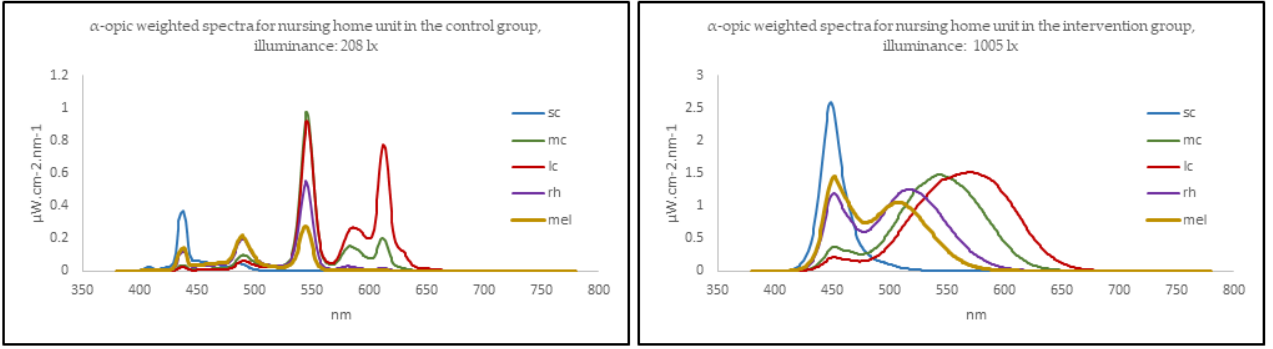
Figure 3. Typical α -opic weighted spectra for nursing home units in the control group ( left ) and the intervention group ( right ). Measured at 1.2 m height, in the center of the room, facing the back wall. Created using the CIE S 026 toolbox [54] .